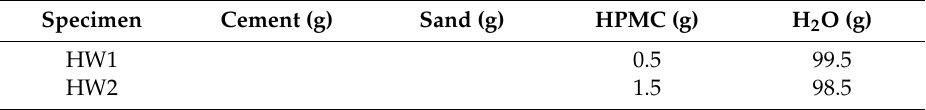
Table 2. Mixture proportions of HPMC (hydroxypropyl-methyl cellulose ether) aqueous